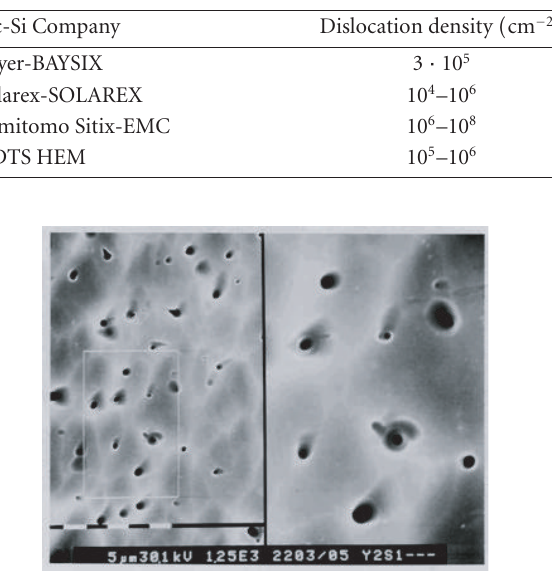
Figure 5: Secco solution detects new defected zones of mc-Si sam- ple initially Yang-etched.